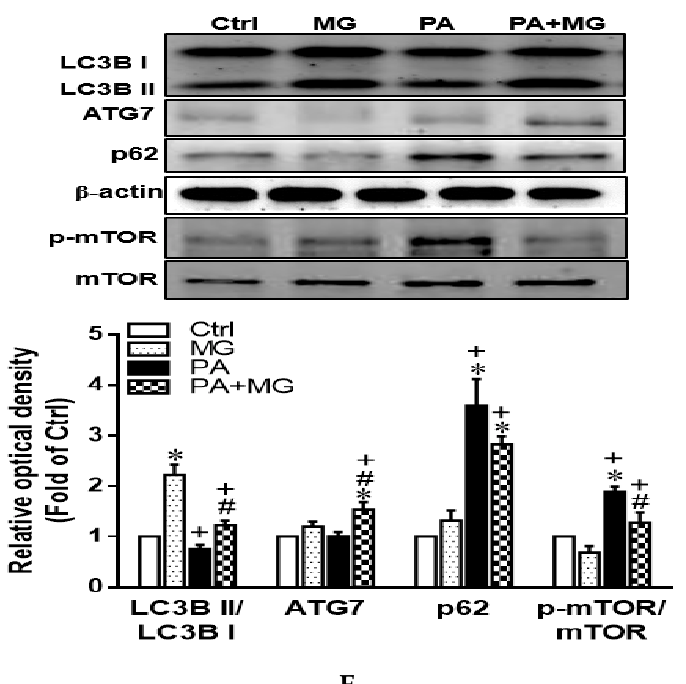
Figure 6. Magnolol (MG) inhibited the activation of NLRP3 inflammasome in PA-induced steatosis and lipopolysaccharide (LPS)-challenged HepG2 cells. ( A ) IL-1 β protein levels in the supernatant fraction of steatotic cells; ( B ) representative Western blot and densitometry analysis of NLRP3, ASC, caspase1 p20, and procaspase1 p50 in steatotic cells; ( C ) IL-1 β protein levels in the supernatant fraction of LPS-challenged cells; ( D ) representative Western blot and densitometry analysis of caspase1 p20, procaspase1 p50, IL-6, and TNF- α in LPS-challenged cells; ( E ) representative Western blot and densitometry analysis of autophagy-related markers LC3B, ATG7, p62 / SQSTM1, and mTOR in steatotic cells. Data are expressed as mean ± SEM, n = 4. * p < 0.05 vs. Ctrl; + p < 0.05 vs. MG; # p < 0.05 vs. PA; & p < 0.05 vs. LPS.